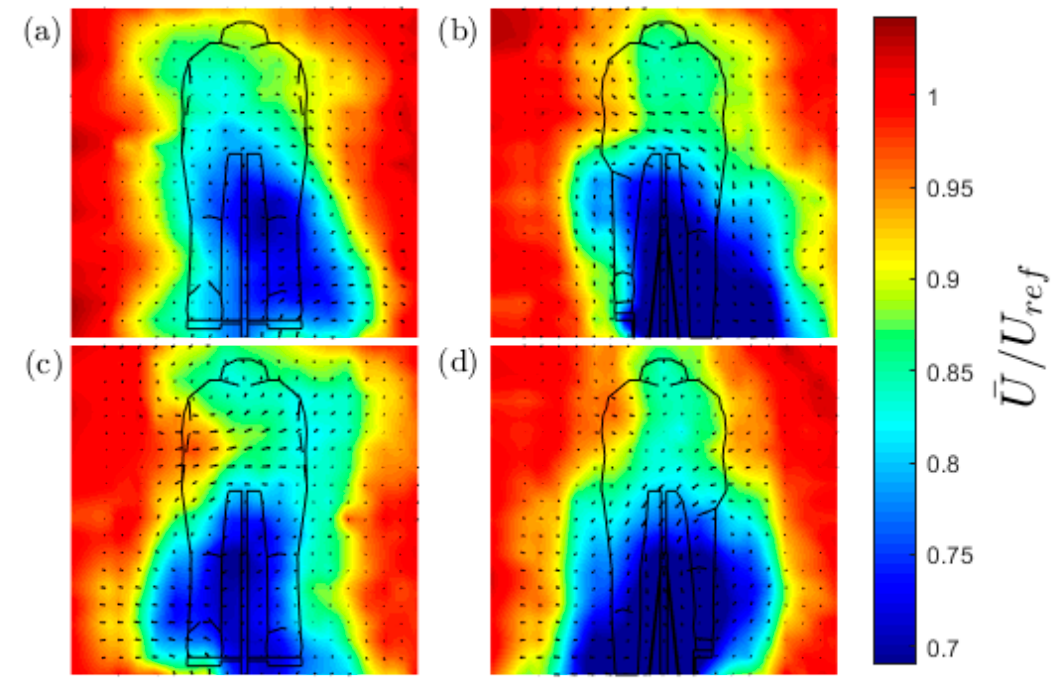
Figure 3. Time-average velocity color contour maps of the streamwise velocity ( u ) and overlaid velocity vectors in the Y - Z planes 2.52 m behind the mannequin in leg positions: ( a ) 0°; ( b ) 90°; ( c ) 180°; and ( d )